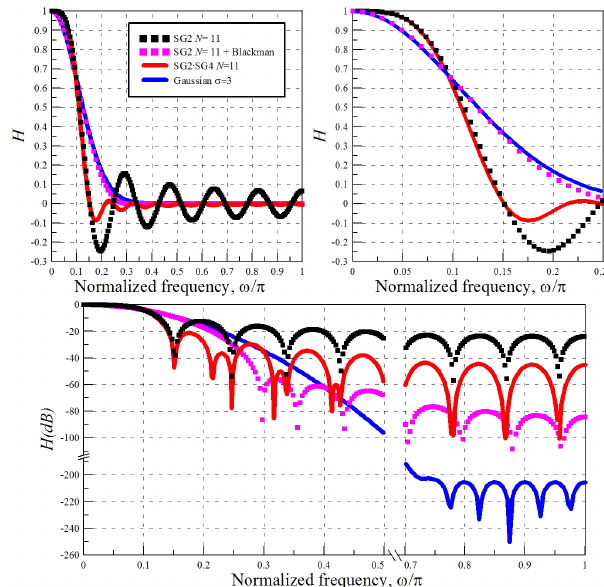
Figure D1. Comparison among filters designed with parameters making their pass bands similar. The upper-left panel shows the dif- ferences in the stop-band regions, due to the presence of side lobes; the SG2 filter (black squares line) has the worst behavior. In the upper-right panel there is a close-up view of the upper-left plot, and the different behavior in the pass bands and transition bands is quite evident. The cascaded SG2 · SG4 and the SG2 filters have the best performances. In the bottom plot, the same frequency responses of the upper plots are reported in decibel